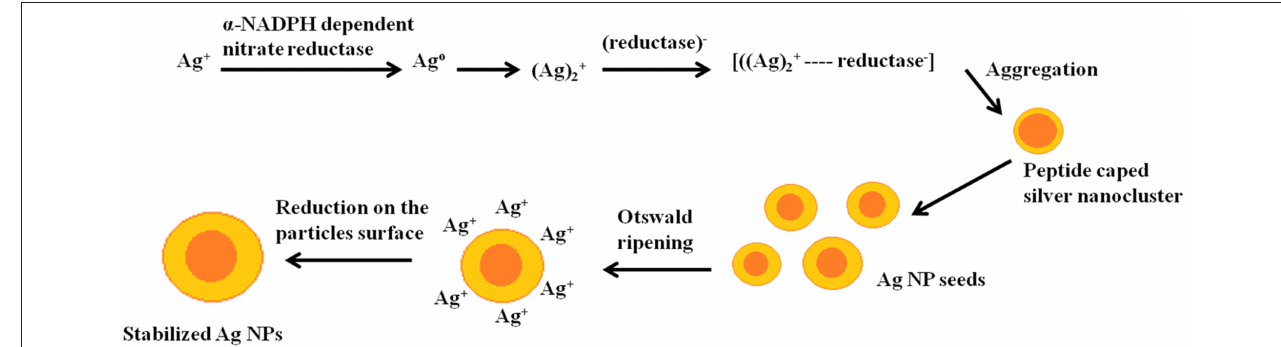
FIGURE 7 | Representation of the reduction and formation of stabilized Ag NPs.